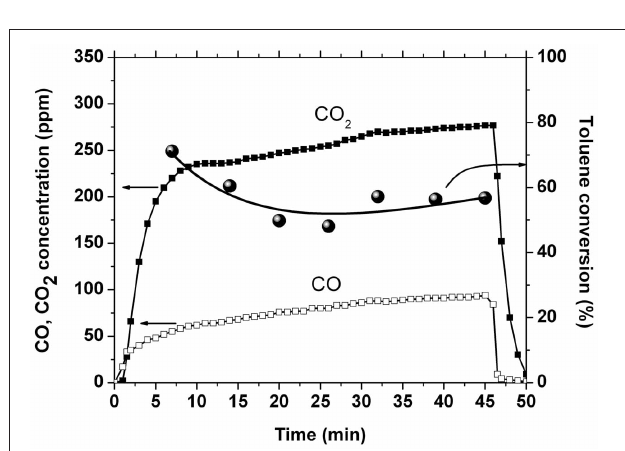
FIGURE 4 | Temporal evolution of CO and CO 2 concentrations and toluene